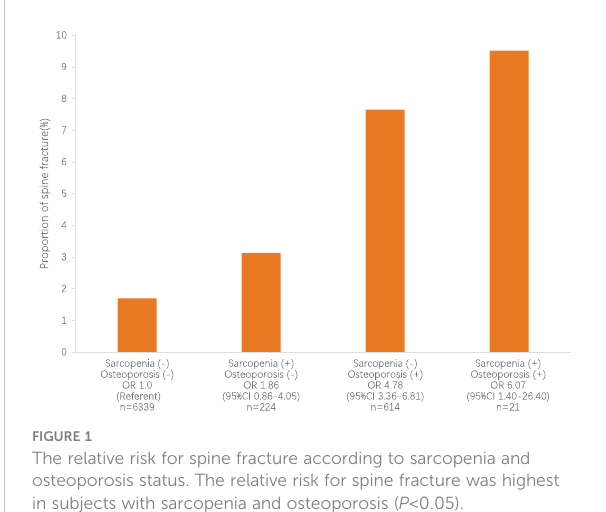
CI, con fi dence interval; OR, odds